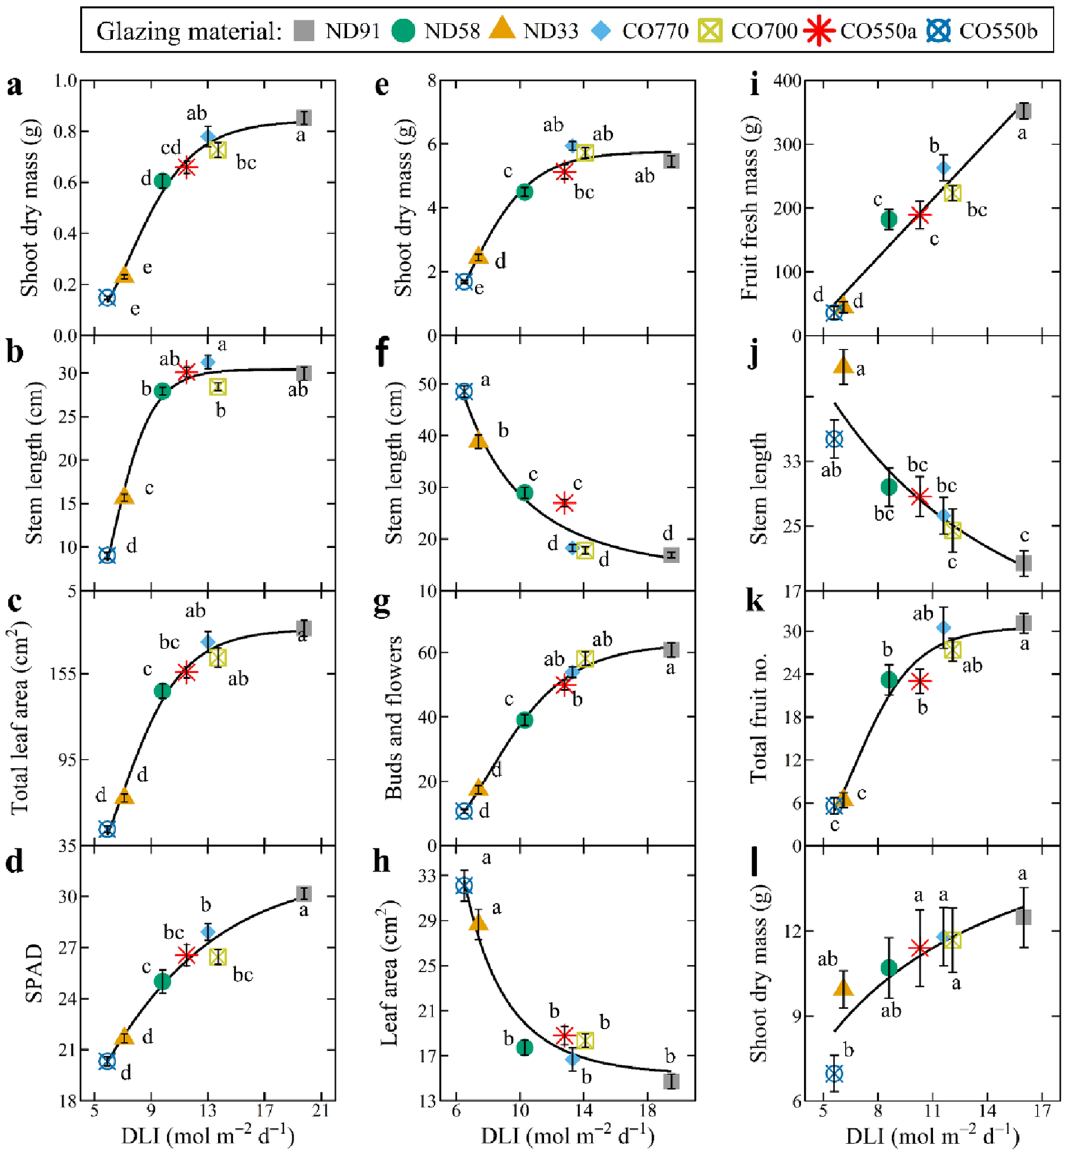
Figure 3. Selected growth response regressions from basil, petunia, and tomato. Growth parameters of basil ( a – d ), petunia ( e – h ), and tomato ( i – l ) under various glazing materials with different spectral transmissions. The transmission spectra for the different glazing materials are given in Fig. 2. Shoot dry mass for basil and tomato refers to both leaves and stems. Data represent means ± SE with ten samples. Means with different letters are significant according to Tukey’s honestly significant difference test ( P < 0.05). Regression equations for basil, petunia, and tomato are presented in Tables S1–S3,